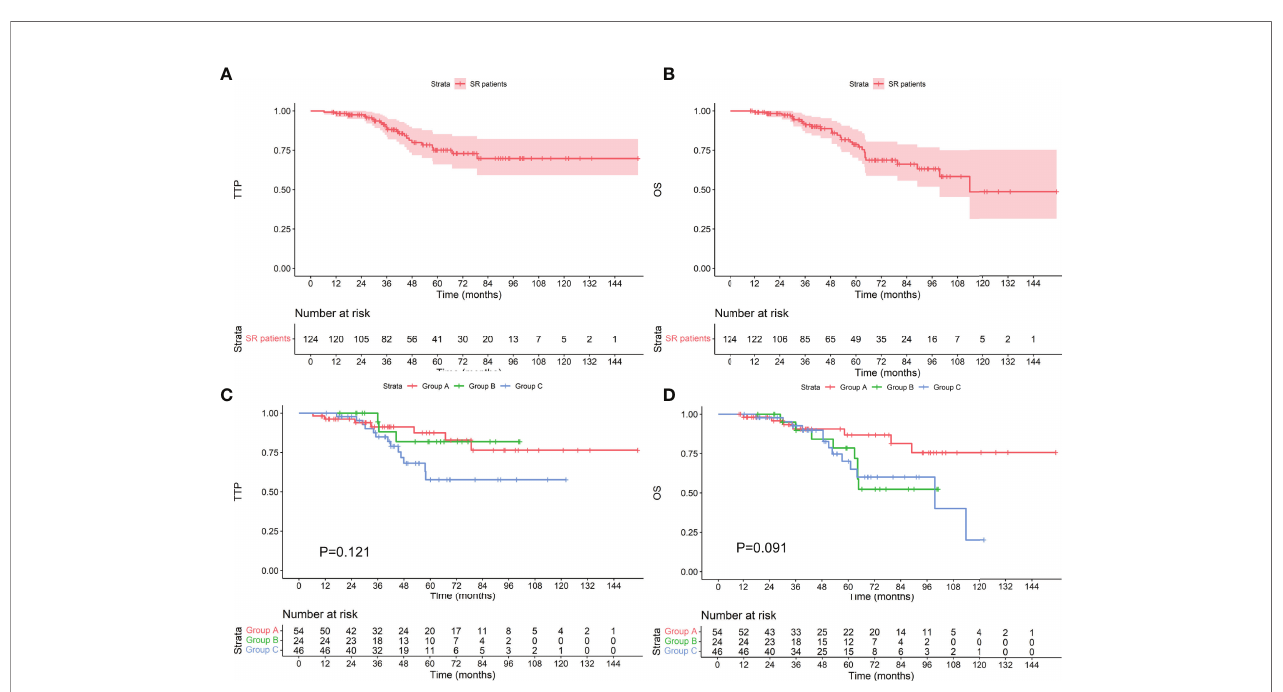
FIGURE 3 | TTP (A) and OS (B) for patients with standard-risk cytogenetics and TTP (C) and OS (D) for patients who achieved an MRD-negative status at different stages. SR, standard-risk